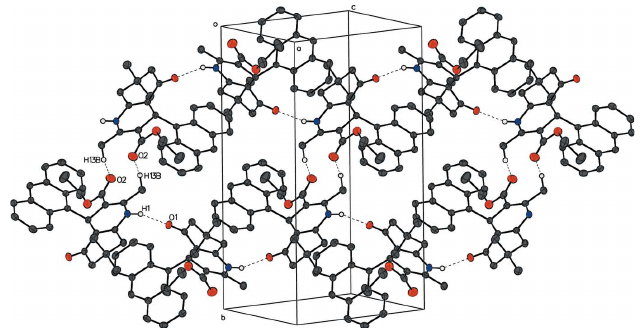
Figure 9 The packing of compound III . Cross-linked zigzag chains of alternating enantiomers form a sheet. For clarity, H atoms not participating in hydrogen bonds are omitted, and participating atoms are labeled once.